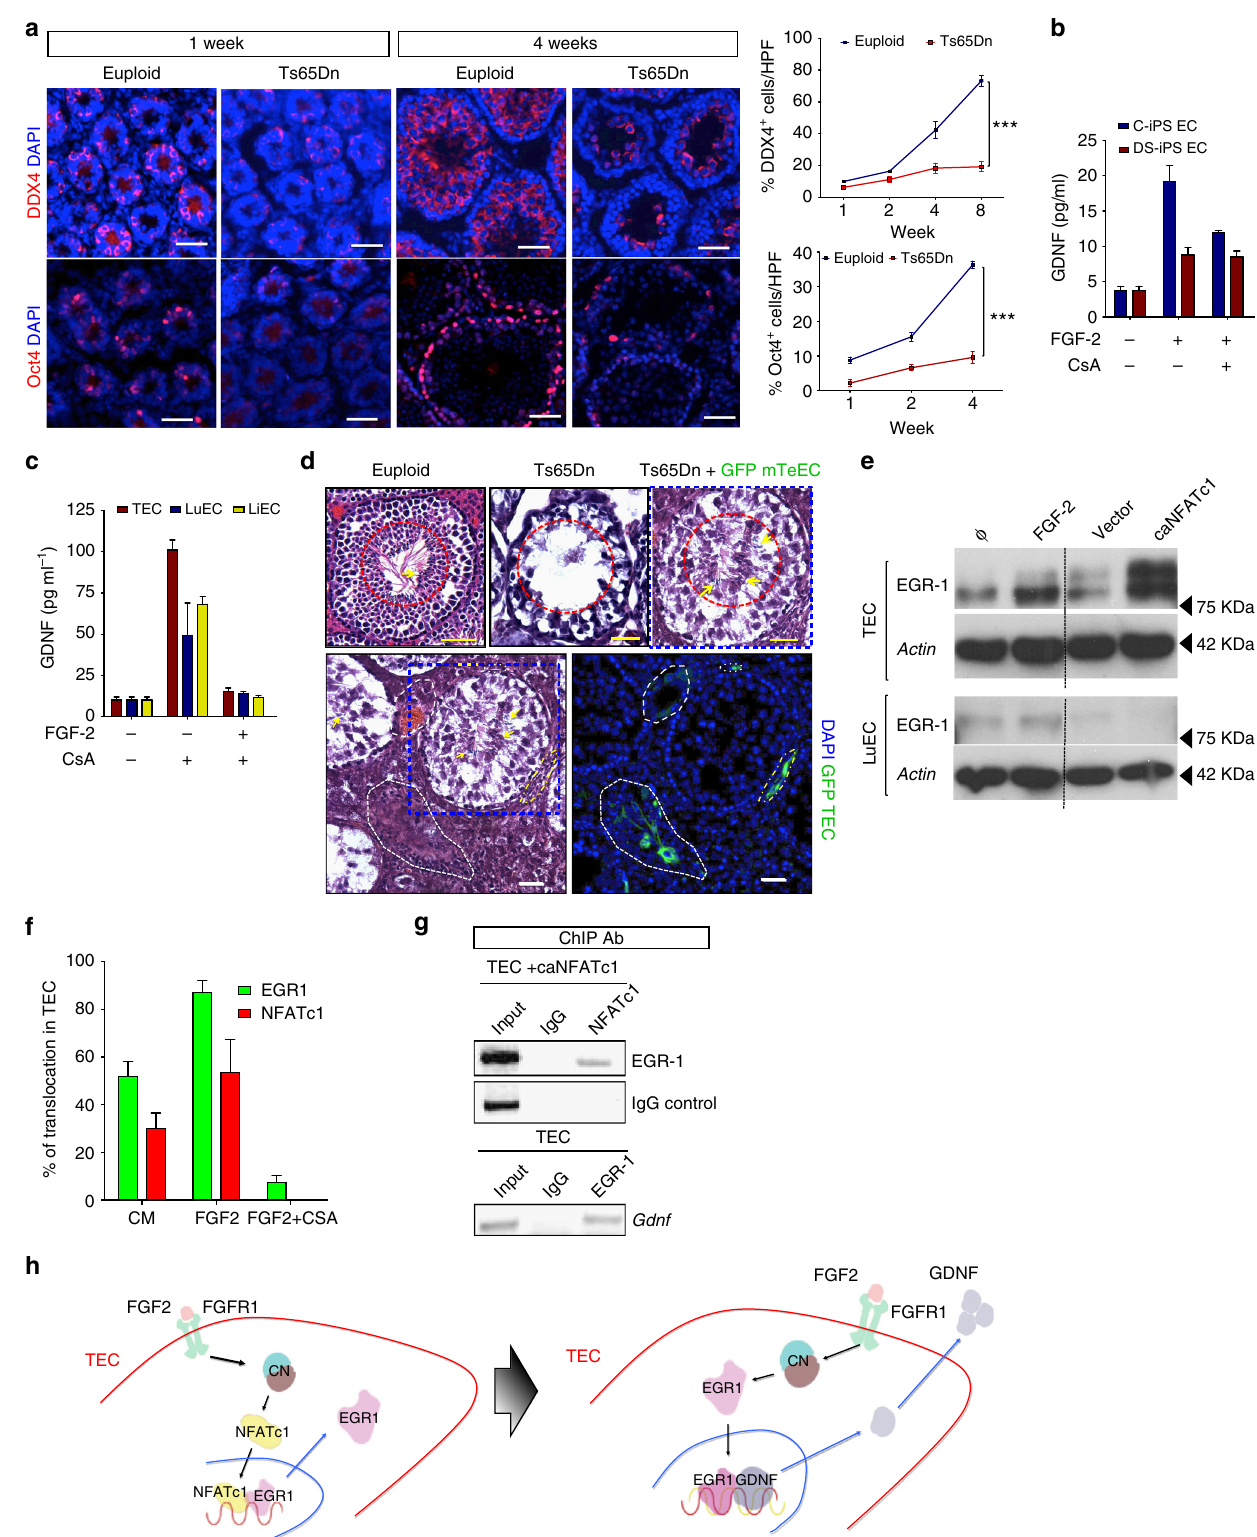
Immuno fl uorescence analysis shows that colonies from human testicular cell/EC co-cultures are positive for SSEA4 and CD49f (Fig. 6b), implicating the presence of SSCs in these colonies. To ensure that human SSCs expanded during long-term EC co- cultures retain their stem cell identity, we dissociated SSC-like